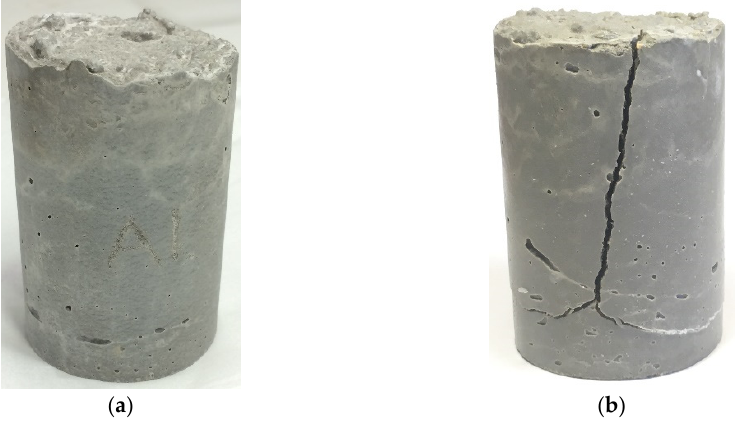
Figure 3. ( a ) Concrete cylinder representative for all samples and time periods except two Al containing cylinders (out of five) exposed for two years and ( b ) Concrete cylinder containing Al that cracked after two years of